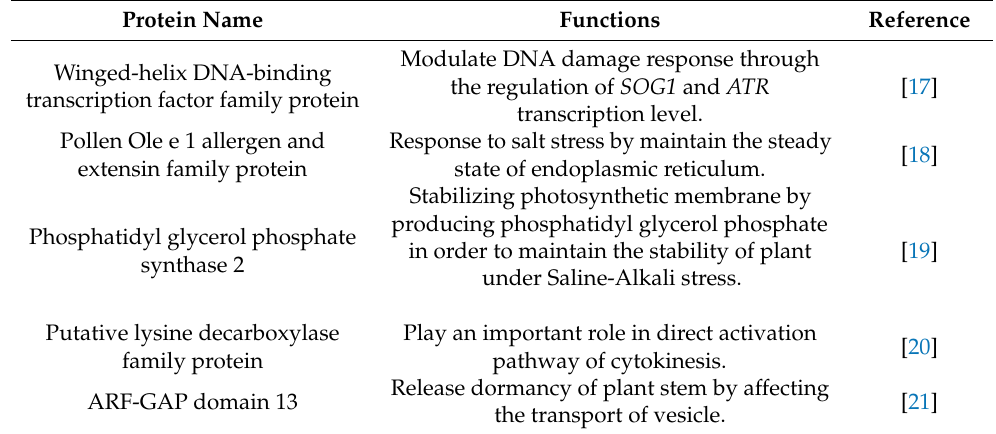
Table 2. The proteins coded by 5 sequences related to Saline-Alkali resistance.